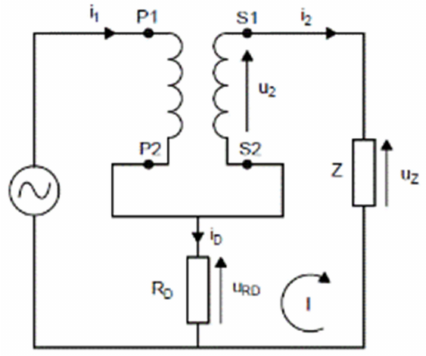
Figure 2. Simplified equivalent diagram of the measuring